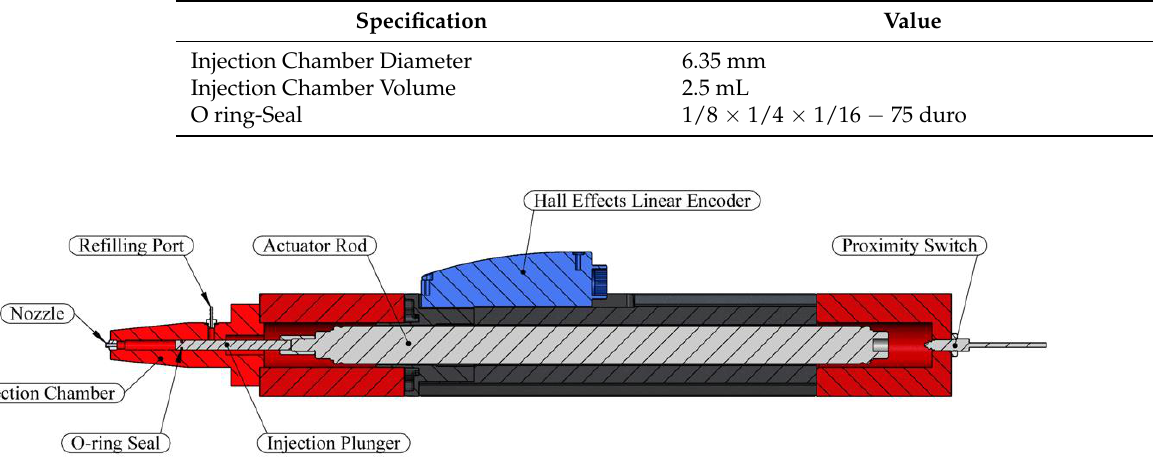
Figure 2. Schematic of complete servo-tube-driven injector.